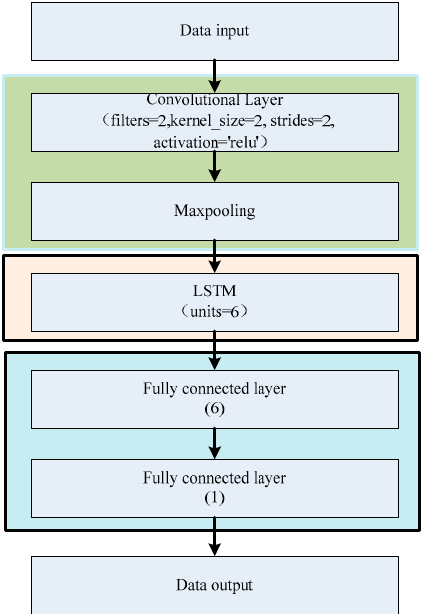
Figure 12. Specific architecture and hyper-parameters.